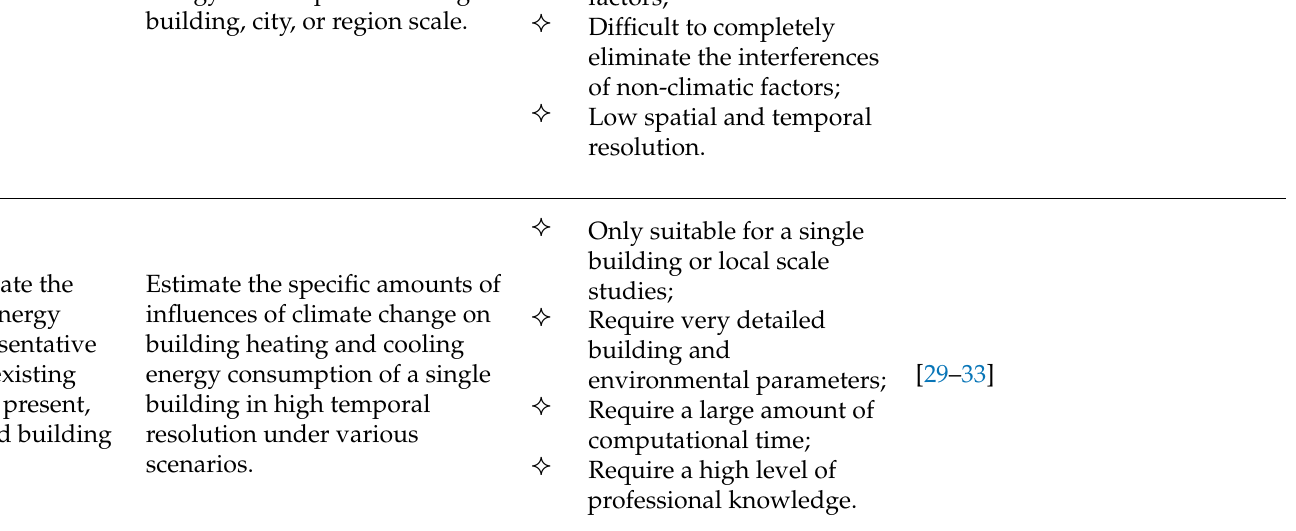
Table 1. Basic operations, advantages, and disadvantages of different methods used to estimate the impacts of climate change on the energy consumption of building heating and cooling.